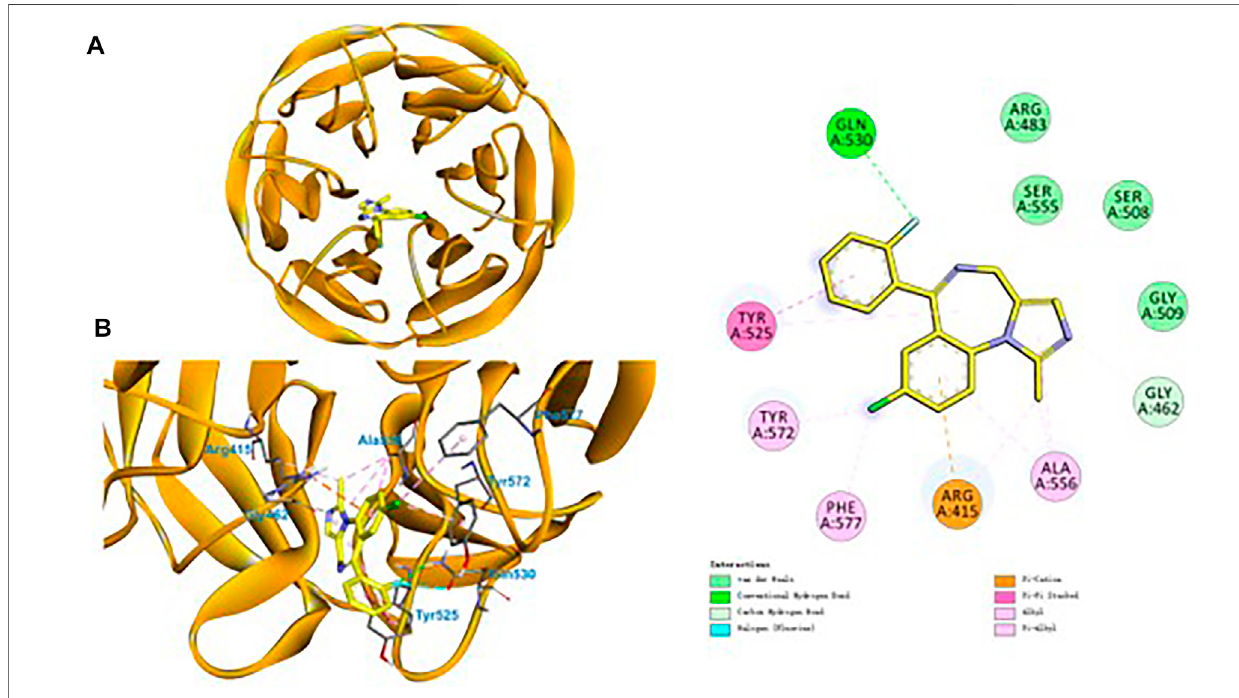
FIGURE 9 | Ligand docking of midazolam in the kelch domain of human Keap1 protein.